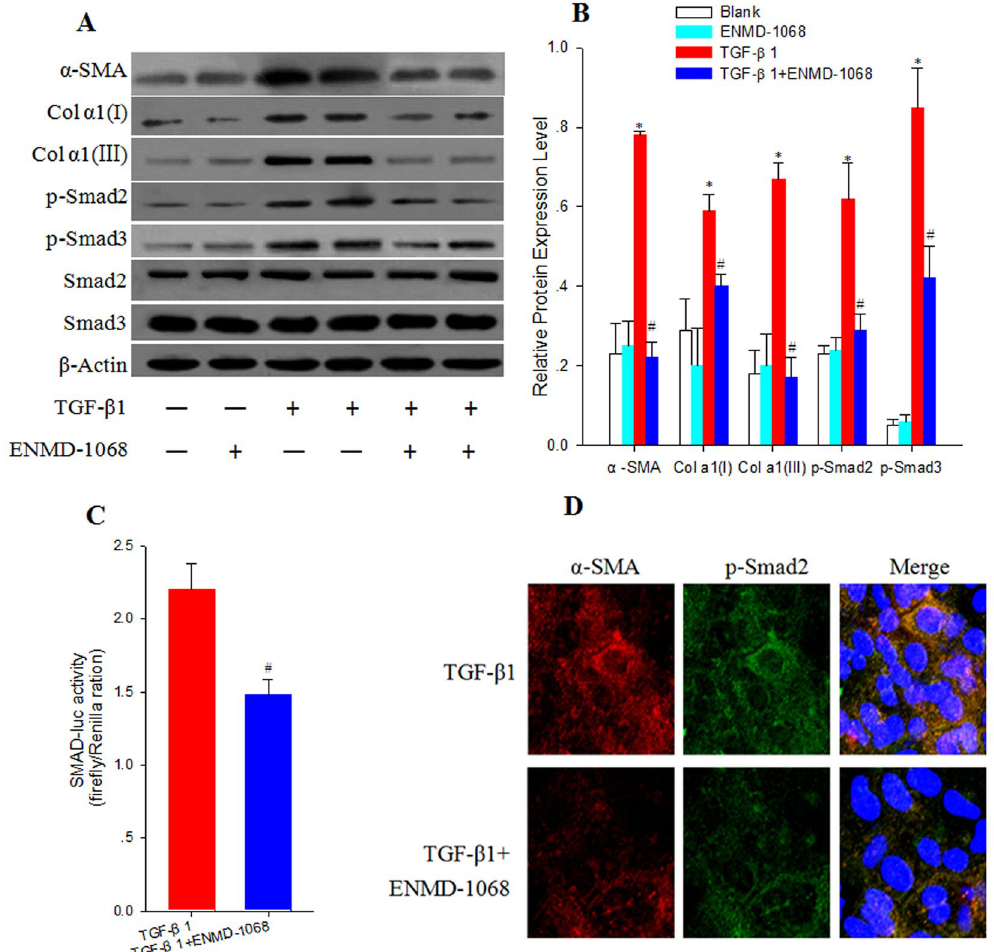
Figure 7. ENMD-1068 reduces HSCs activation and collagen production through the inhibition of TGF- β 1/ Smad signal transduction. ( A ) immunoblotting for α -SMA, Collagen I, Collagen III, and Smad2/3 C-terminal phosphorylation following stimulation with TGF- β 1 (5 ng/mL) for 24 h in the presence or absence of the selective inhibitor of PAR-2 (ENMD-1068, 10 mM). ( B ) histogram showing densitometry analysis and quantification of α -SMA, Collagen I, Collagen III, and Smad2/3 C-terminal phosphorylation. The signals for α -SMA, Collagen I, Collagen III, p-Smad2C and p-Smad3C were normalized to respective bands for β -actin and/or Smad2/3. ( C ) Primary mouse HSCs were cotransfected with SMAD luciferase reporter plasmid and pRL-TK vector. Twenty-four hours after transfection, cells were treated with TGF- β 1(5 ng/mL) in the presence or absence of ENMD-1068 (10 mM) for another 24 h. Luciferase activity was determined with the commercial luciferase reporter assay system. ( D ) Confocal microscopy images displayed the subcellular localization of α -SMA (red) and p-Smad2 (green) in merged image panels. The nuclei were stained with 4 ′ ,6-diamidino-2- phenylindole (DAPI; blue)( × 200). (mean ± SD; * P < 0.05 vs Blank; # P < 0.05 vs TGF- β 1 treatment, N =